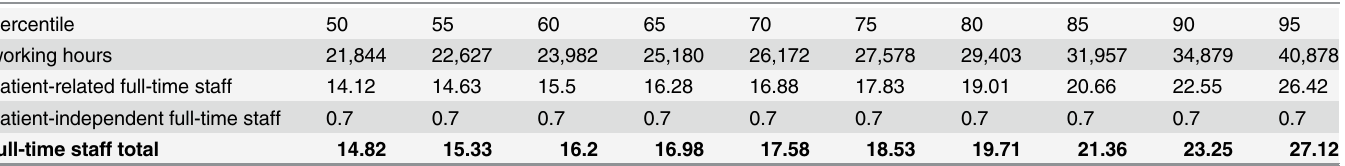
Table 2. Calculated number of full-time staff *